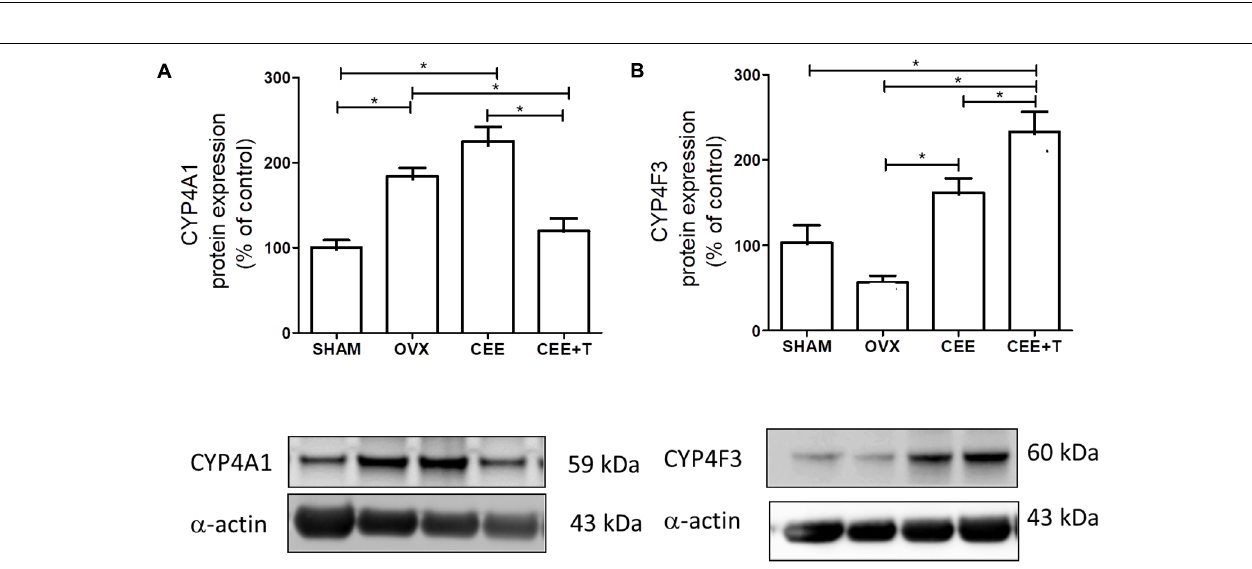
FIGURE 4 | Immunoblot representative images (bottom) and densitometric analyses (top) of protein expression of CYP4A1 (A) and CYP4F3 (B) , normalized by α -actin, in aorta of SHAM, ovariectomized (OVX), OVX treated with conjugated equine estrogens (CEE) and OVX treated with CEE plus testosterone (CEE+T) female spontaneously hypertensive rats. Results were expressed as percentage of SHAM and represent the mean ± SEM from 6 to 7 independent experiments. One-way ANOVA: ∗ P < 0.05.